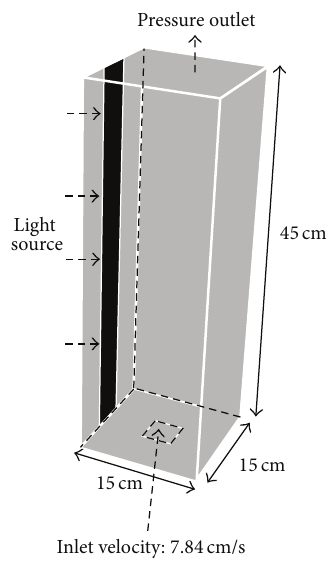
Figure 1: Geometry and boundary conditions for the bubble column